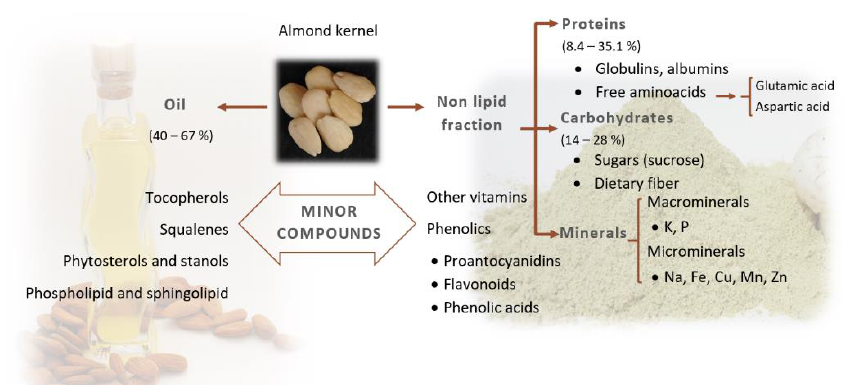
Figure 1. Chemical composition of almond kernel.